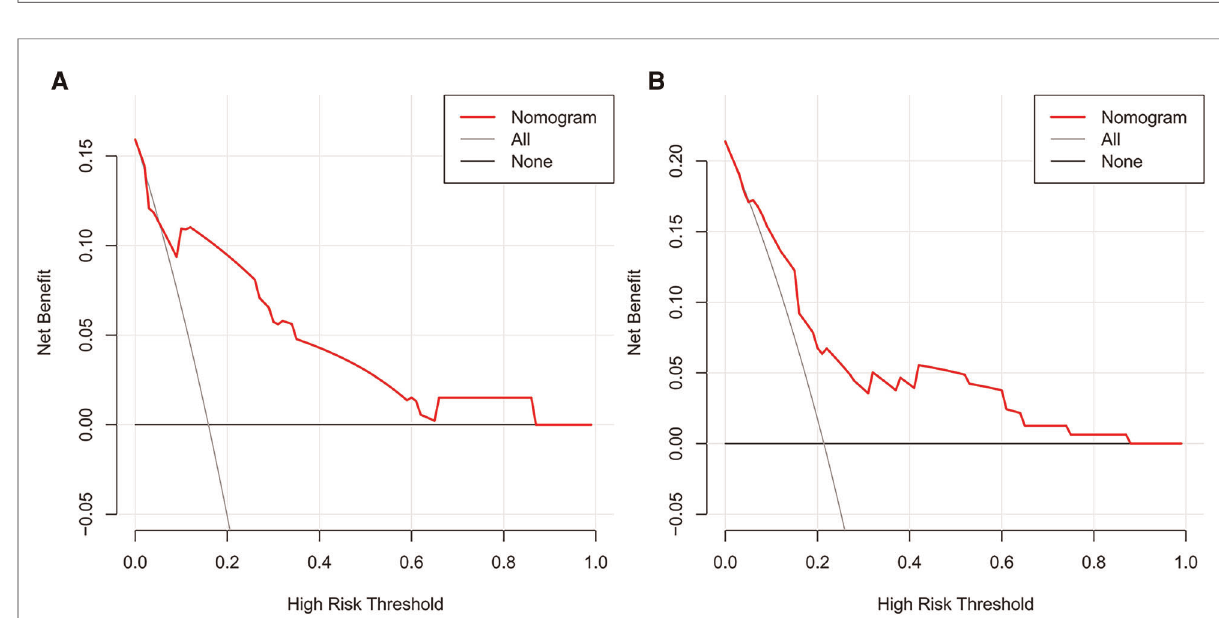
FIGURE 4 Calibration curves of the nomograms for left and right RLN LNM prediction. The calibration curves demonstrated that the predicted probability by nomogram was closely aligned with the actual estimates in both left ( A ) and right ( B ) cohorts, indicating that there was good agreement. RLN LNM, recurrent laryngeal nerve lymph node metastasis.